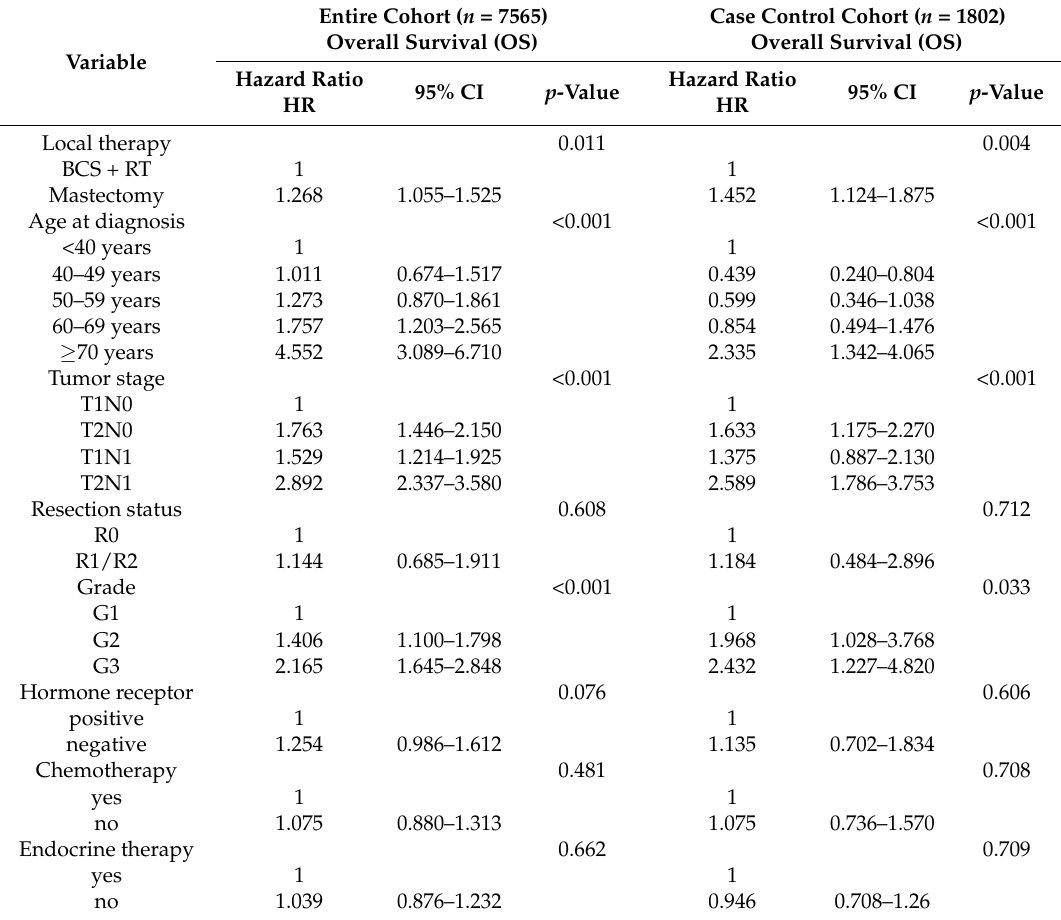
Table 6. Multivariable Cox regression analysis for overall